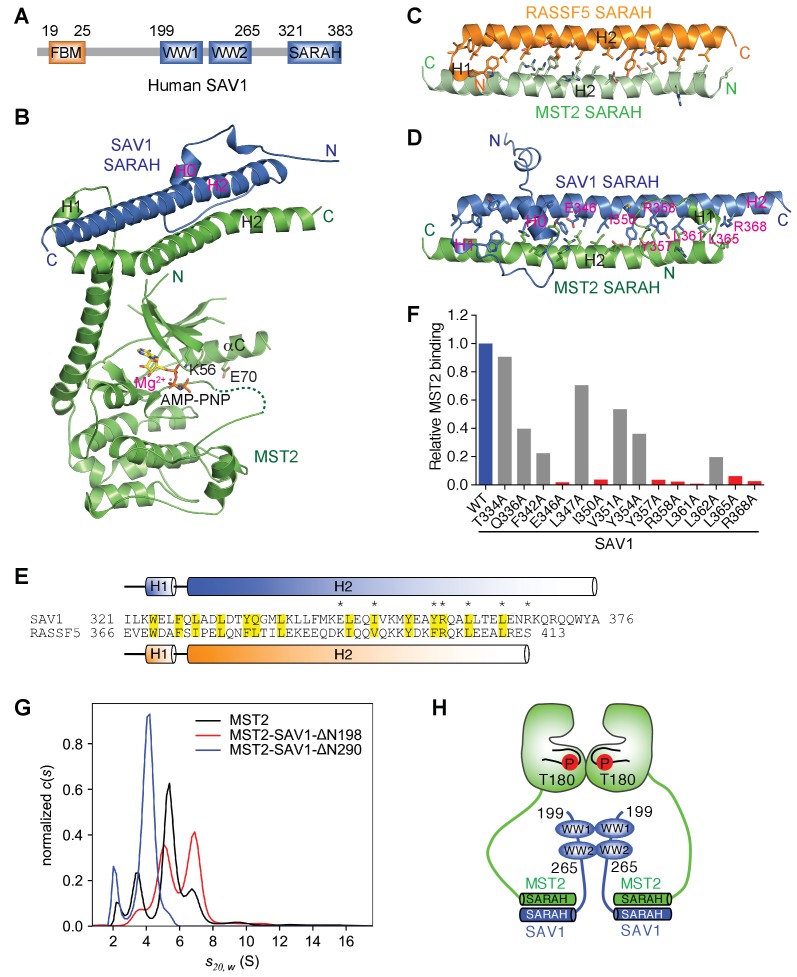
Crystal structure and binding interface of human MST2-SAV1.(A) Schematic drawing of domains and motifs of human SAV1. (B) Cartoon drawing of the crystal structure of the MST2-SAV1 complex. MST2 is colored green, and SAV1 is colored blue. Side chains of K56 and E70, and AMP-PNP are shown as sticks. Mg2+ is shown as a magenta sphere. The disordered T-loop is drawn as a green dashed line. (C) Cartoon drawing of the crystal structure of the MST2 SARAH-RASSF5 SARAH heterodimer (PDB ID: 4LGD). MST2 and RASSF5 are colored in light green and orange, respectively. The interface residues are shown as sticks. (D) Cartoon drawing of the crystal structure of the MST2 SARAH-SAV1 SARAH heterodimer (this study). MST2 and SAV1 are colored in green and blue, respectively. The interface residues are shown as sticks. SAV1 residues whose mutations cause defective MST2 binding are labeled in magenta. (E) Sequence alignment of SARAH domains of human SAV1 and RASSF5. The highly conserved interface residues are shaded in yellow. Seven interface residues whose mutations cause defective MST2 binding are marked by asterisks. The secondary structural elements of SAV1 SARAH are shown above the sequences and colored blue. The secondary structural elements of RASSF5 SARAH are shown below the sequences and colored orange. (F) Quantification of the relative binding intensity between MST2 SARAH domain (residue 431–491) and SAV1 SARAH domain (residue 321–383) and its mutants, derived from the pull-down experiments. Relative MST2 binding of the indicated SAV1 mutant is normalized against SAV1 wild type (WT; 100%). SAV1 mutants that lost or retained MST2 binding are colored red and gray, respectively. (G) Sedimentation velocity analytical ultracentrifugation analysis of MST2-FL (black), MST2-FL/SAV1-ΔN198 (red), and MST2-FL/SAV1-ΔN290 (blue). ‘s20,w’, sedimentation coefficient corrected to standard conditions; S, Svedberg units (10−13 seconds). (H) Schematic model of the MST2-SAV1 heterotetramer.